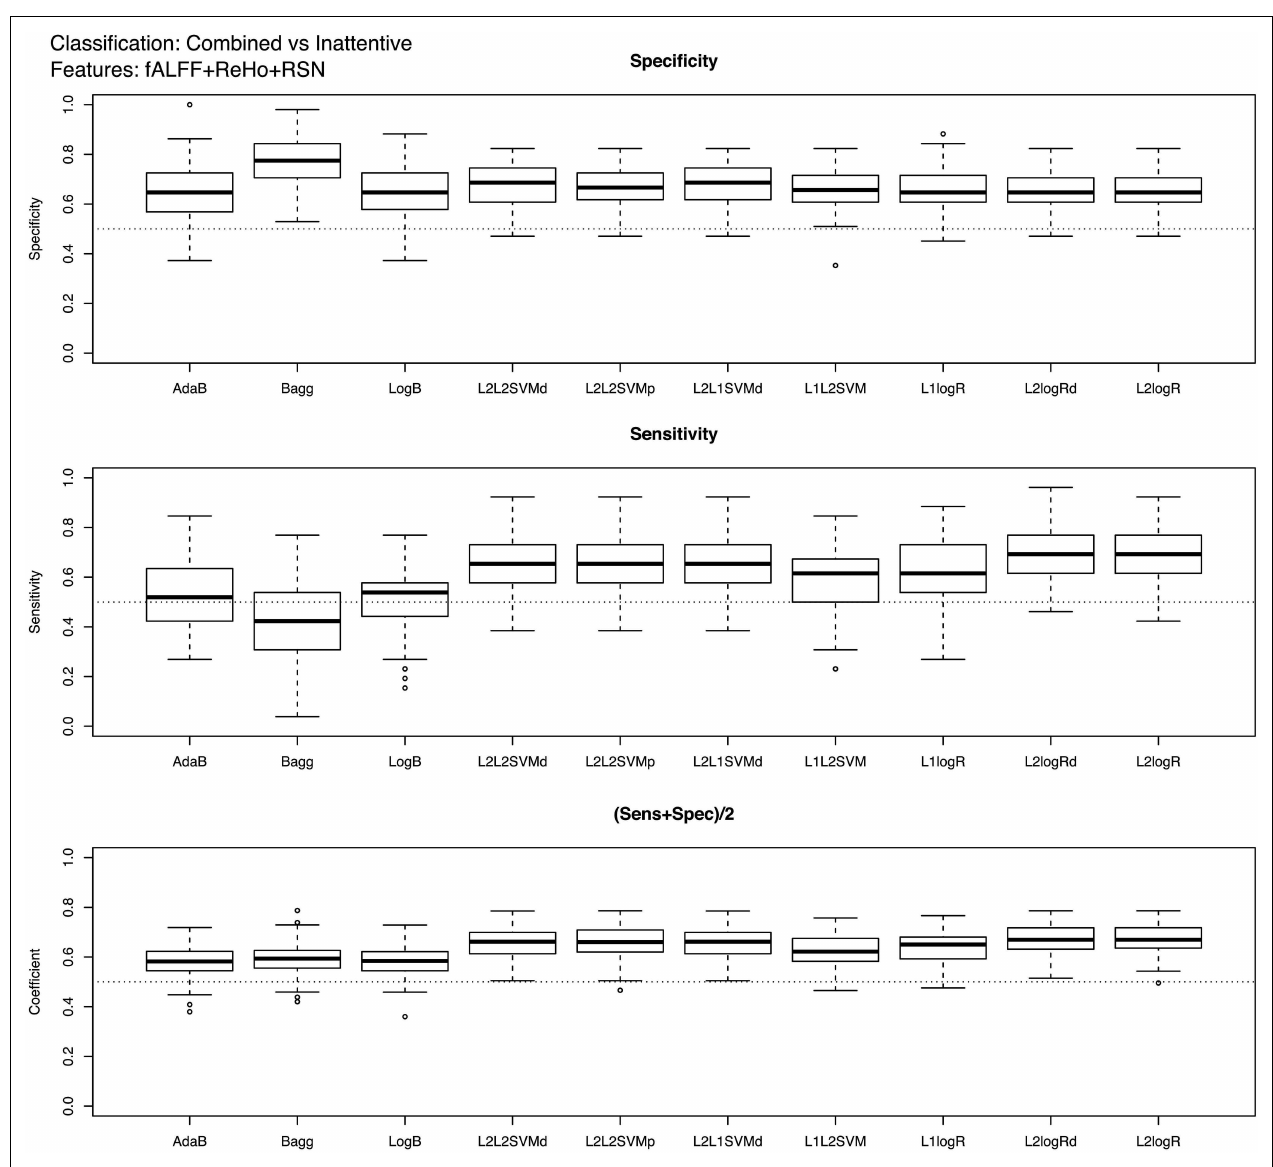
FIGURE 3 | Boxplots of the performance measures in combined vs. inattentiveADHD patients classification when using fALFF + REHO + RSN4